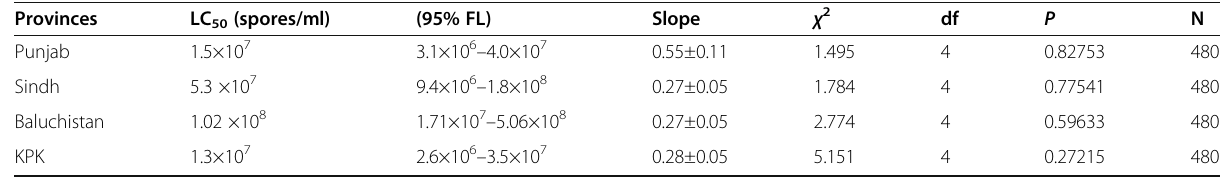
Table 1 Virulence of Beauveria bassiana against Rhynchophorus ferrugineus from Pakistan